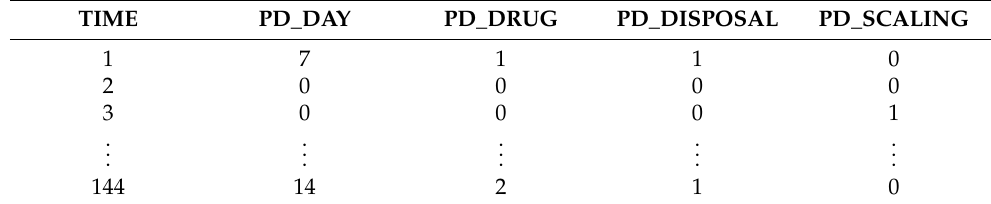
Table 3. The disease course matrix representation of the patient whose ID was 8f14 (one month is the unit of a time series data, k =